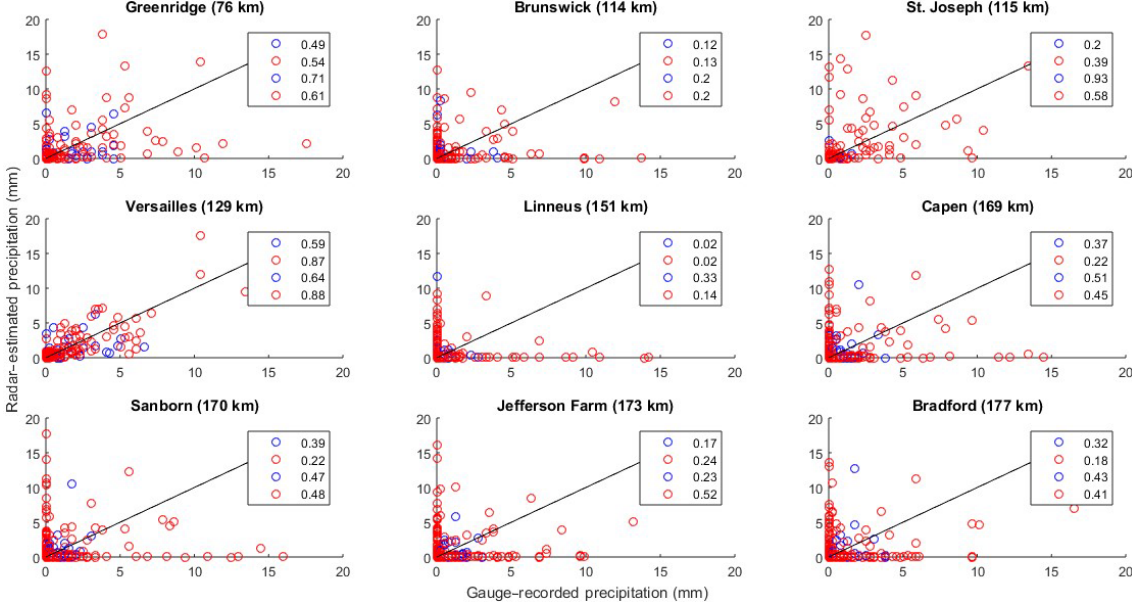
Figure 4. Correlation coefficient values for the nine locations analyzed by the Kansas City radar with the R ( Z ,ZDR) NSSL equation. Blue and red scatter points represent the cool and warm season data, respectively. The top two numbers on each plot indicate the overall R 2 value, whereas the bottom two numbers represent the R 2 when false alarms and misses are